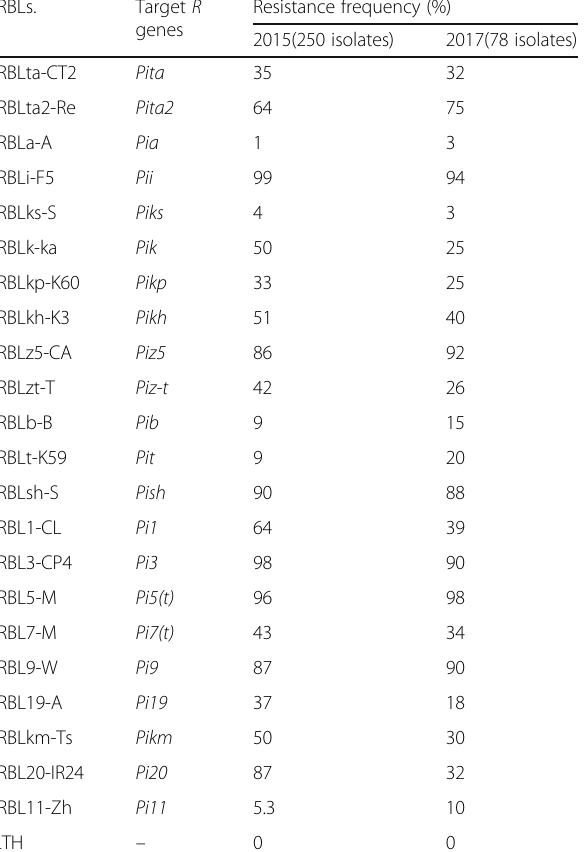
Table 2 Resistance frequency of different IRBLs to the rice blast isolates collected in Bohol in 2015 and 2017. -: no target R gene